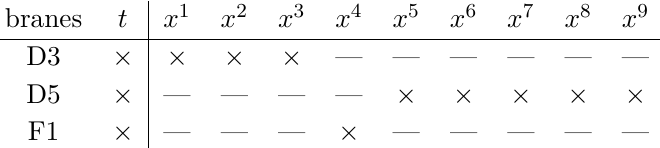
strings dissolved in their worldvolumes. This is the realisation in the near horizon limit of a configuration of M stacks of D5-branes separated a distance L from N D3-branes, with ( m ) F1-strings stretched between the stacks. The brane set-up is depicted , m , . . . m 1 2 M